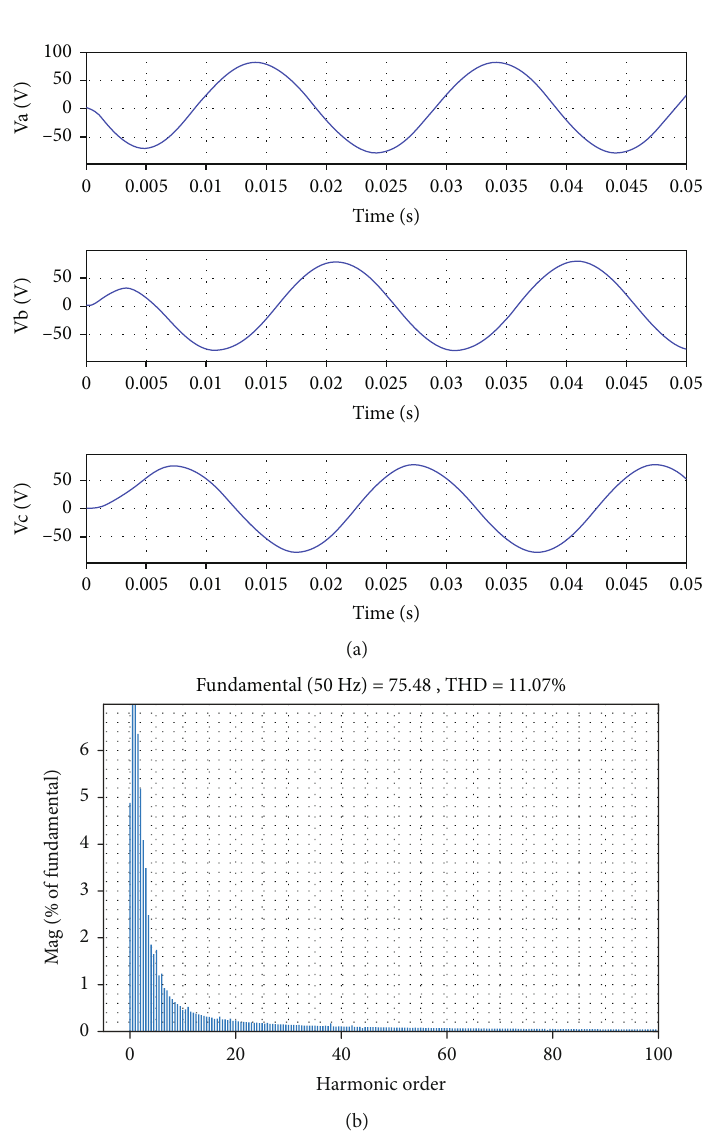
Figure 9: Filtered line voltages ( V